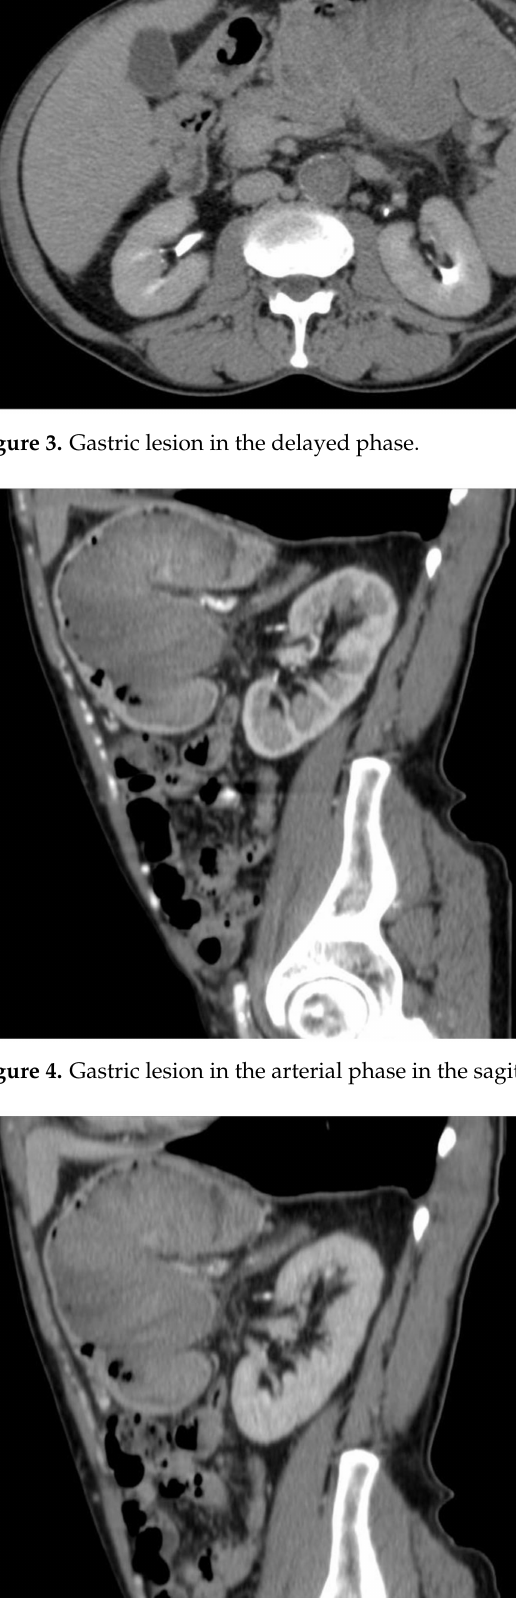
Figure 5. Gastric lesion in the venous phase in the sagittal